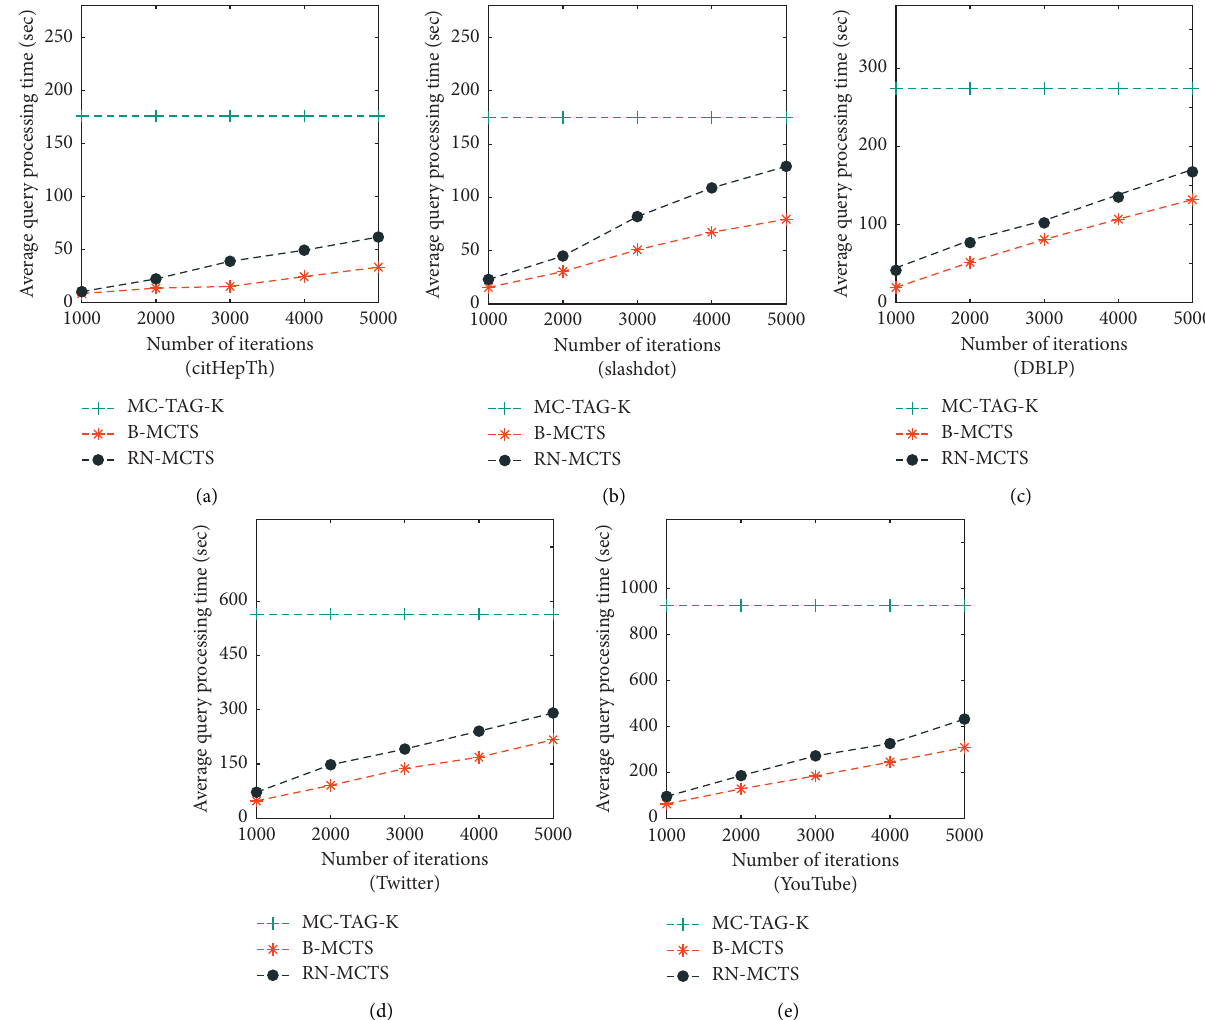
Figure 5: The average query processing time based on different iterations.